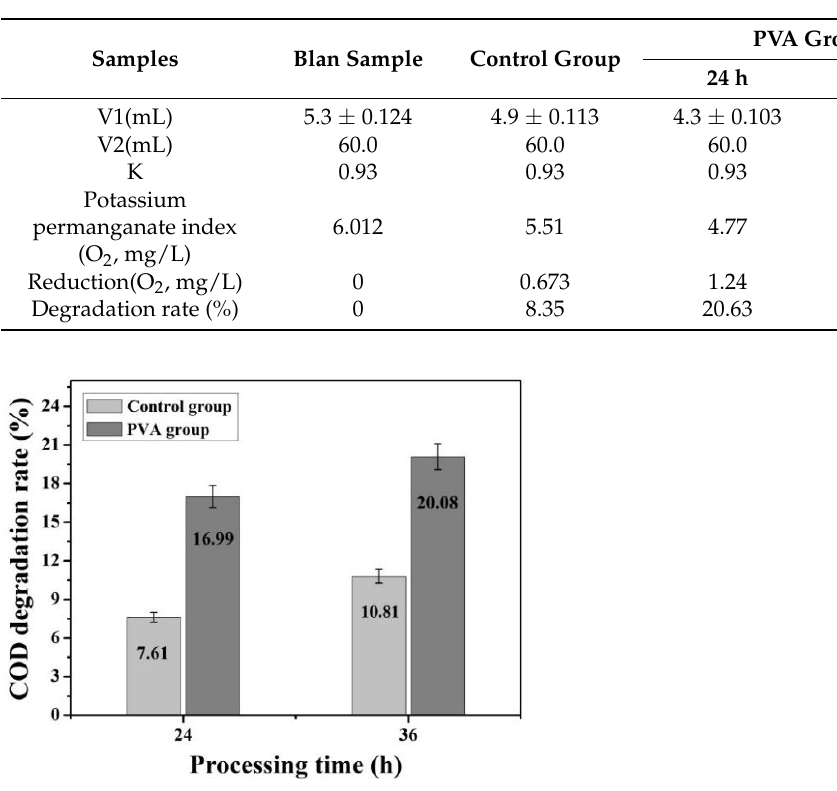
Table 2. The degradation of microspheres-immobilized Bacillus velezensis strain treating 50% con- centration slaughter wastewater.